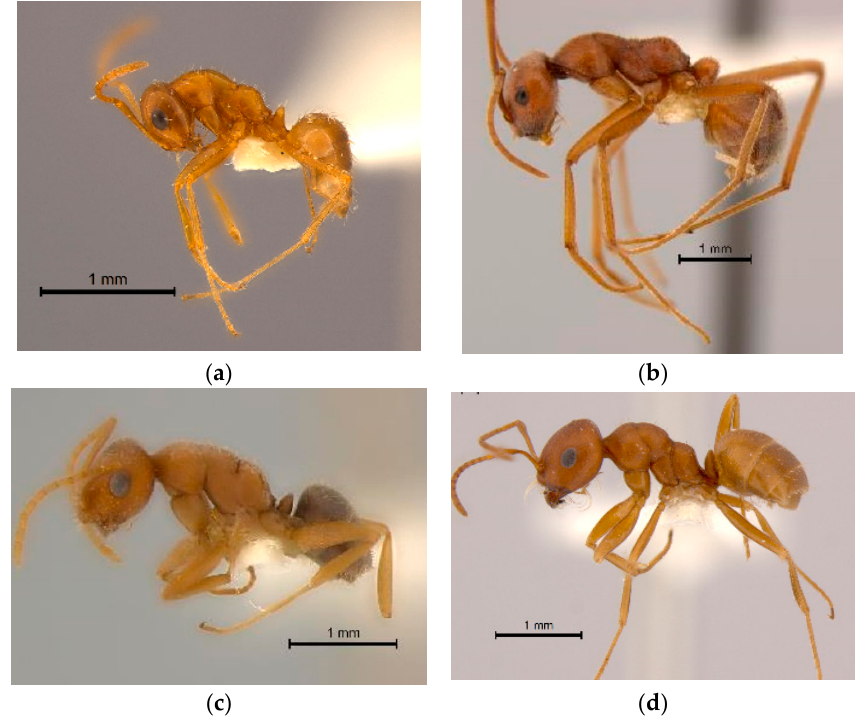
Figure 4. Representatives of the M. fulvihirtus radiation. ( a ) Member of the M . Group I; ( b ) M. anderseni ; ( c ) M. fulvihirtus ; and ( d ) member of Melophorus Group G.